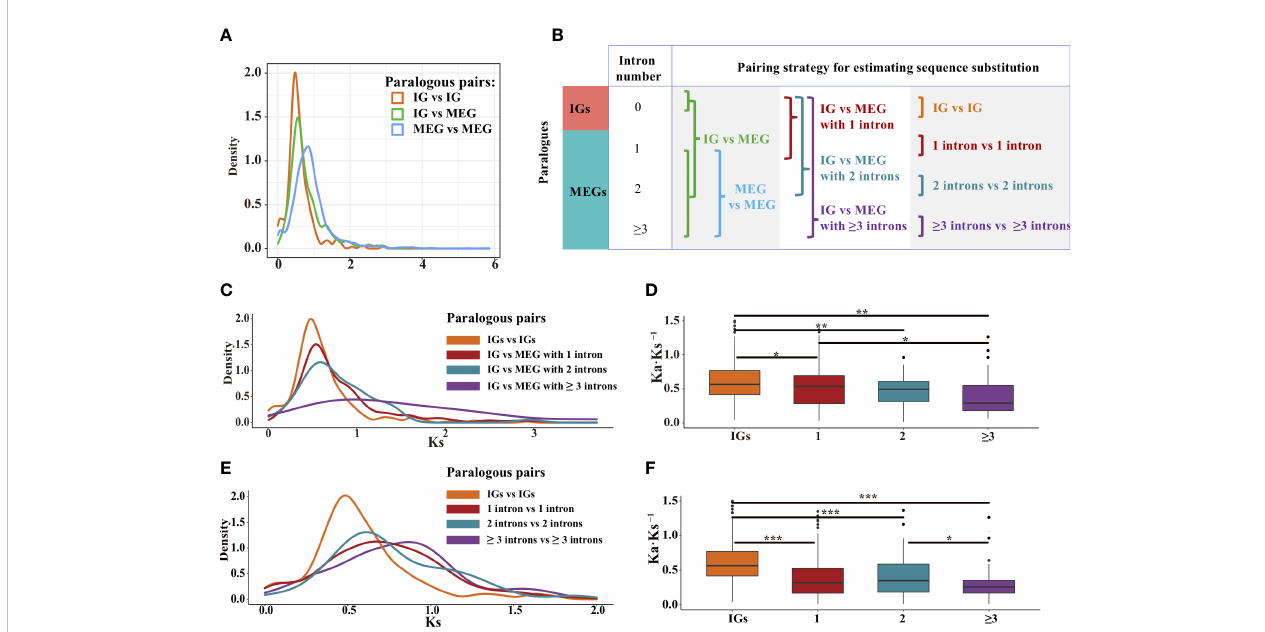
FIGURE 6 Distribution of the Ks and Ka·Ks − 1 values for the paralogous pairs in rice. (A) Density plot of the Ks values for three paralogous sets: intronless [IG vs. IG], transition (IG vs. MEG), and multiexon (MEG vs. MEG). (B) Paralogous pairing strategy. (C, D) Paralogous pairs between IGs and MEGs with one, two, and three or more intron(s). (E, F) Paralogous pairs of genes with the same number of introns. The boxplots present the median, upper, and lower quartiles and 95% con fi dence intervals for Ka·Ks − 1 . Points indicate outliers in the data. Asterisks represent signi fi cant differences (two-sided paired Wilcoxon sign test: * P < 0.05, ** P < 0.01, and *** P <